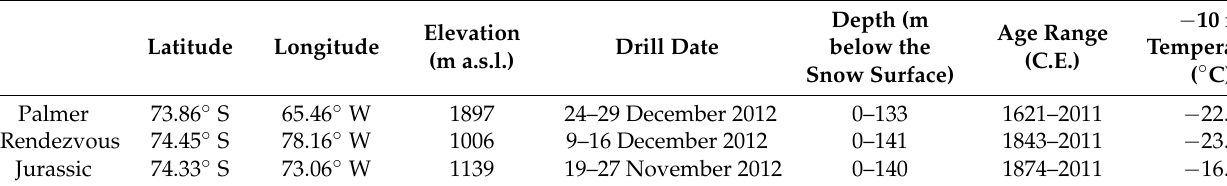
Table 1. Drill site and core characteristics.